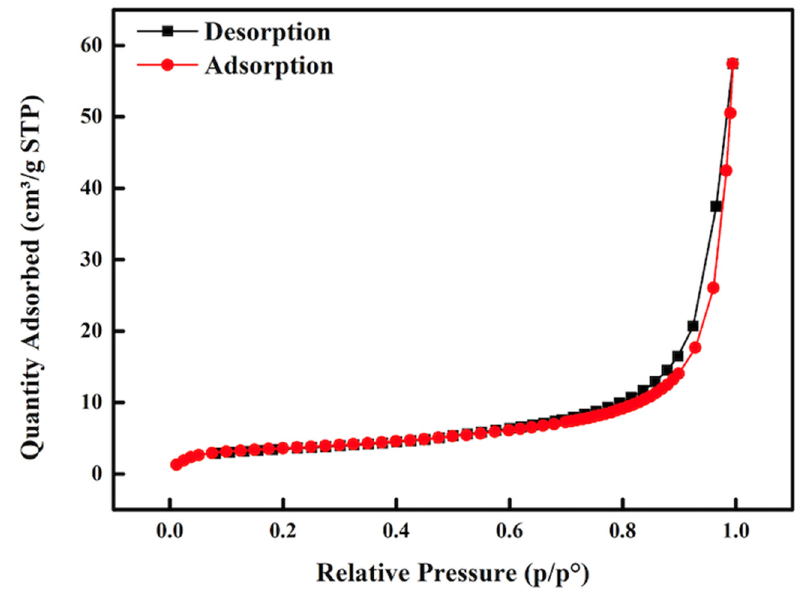
Figure 4. Nitrogen Adsorption-desorption isotherm of CaO/Al 2 O 3. Table 2. Textural properties and surface area analysis.